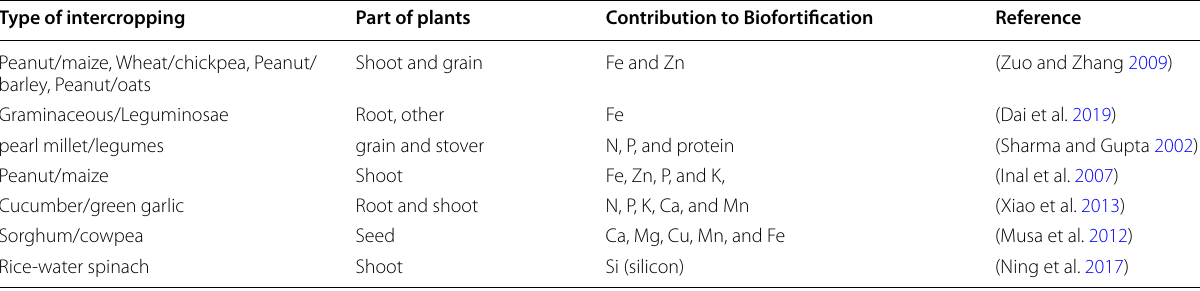
Table 1 Summary of studies showing the potential of cereal/legume intercropping those contribute to alleviating micronutrient deficiency Type of intercropping Part of plants